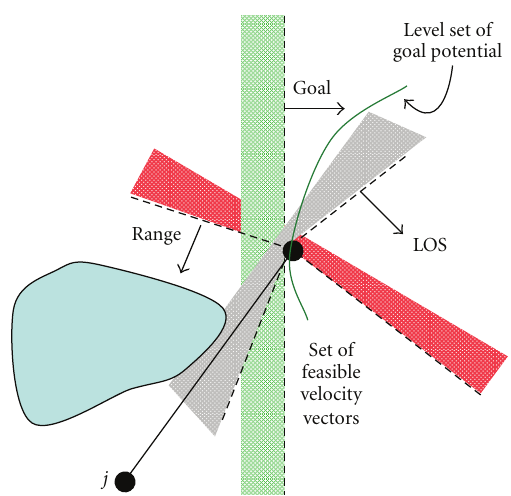
Figure 5: An illustration of the velocity selection problem for robot i . u α is the set of all vectors in the same half plane as − ∂φ goal (labeled as Goal ). Similarly, the range and line of sight constraints define cones in the tangent space. The set of feasible directions lies at the intersection of these sets.